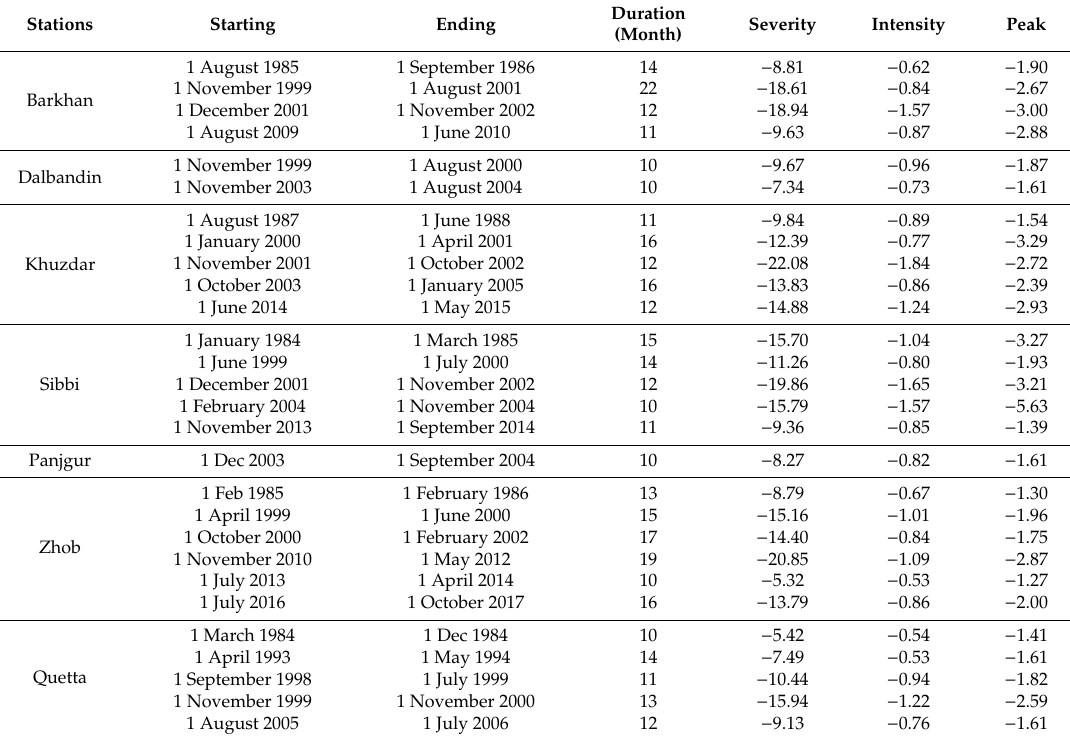
Table 3. Droughts with durations of at least 10 months by the station with their characteristics. Stations Starting Ending